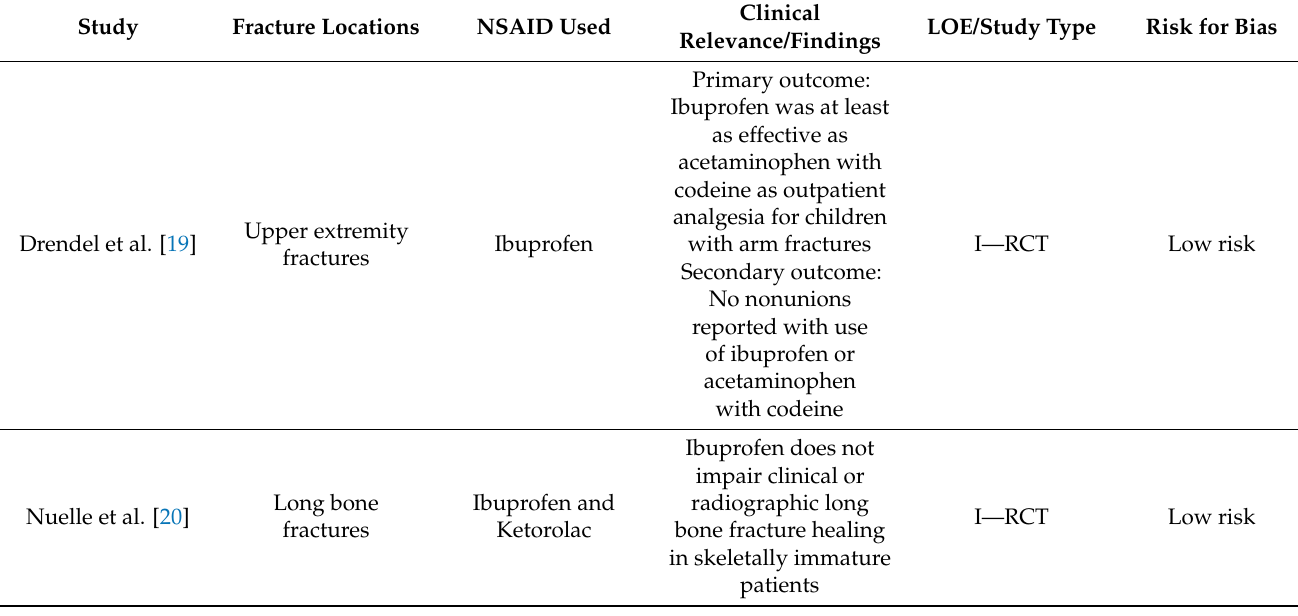
Table 2. Synthesis of Examined Studies Evaluating Effect of NSAIDs on Bone Healing in Skeletally Immature